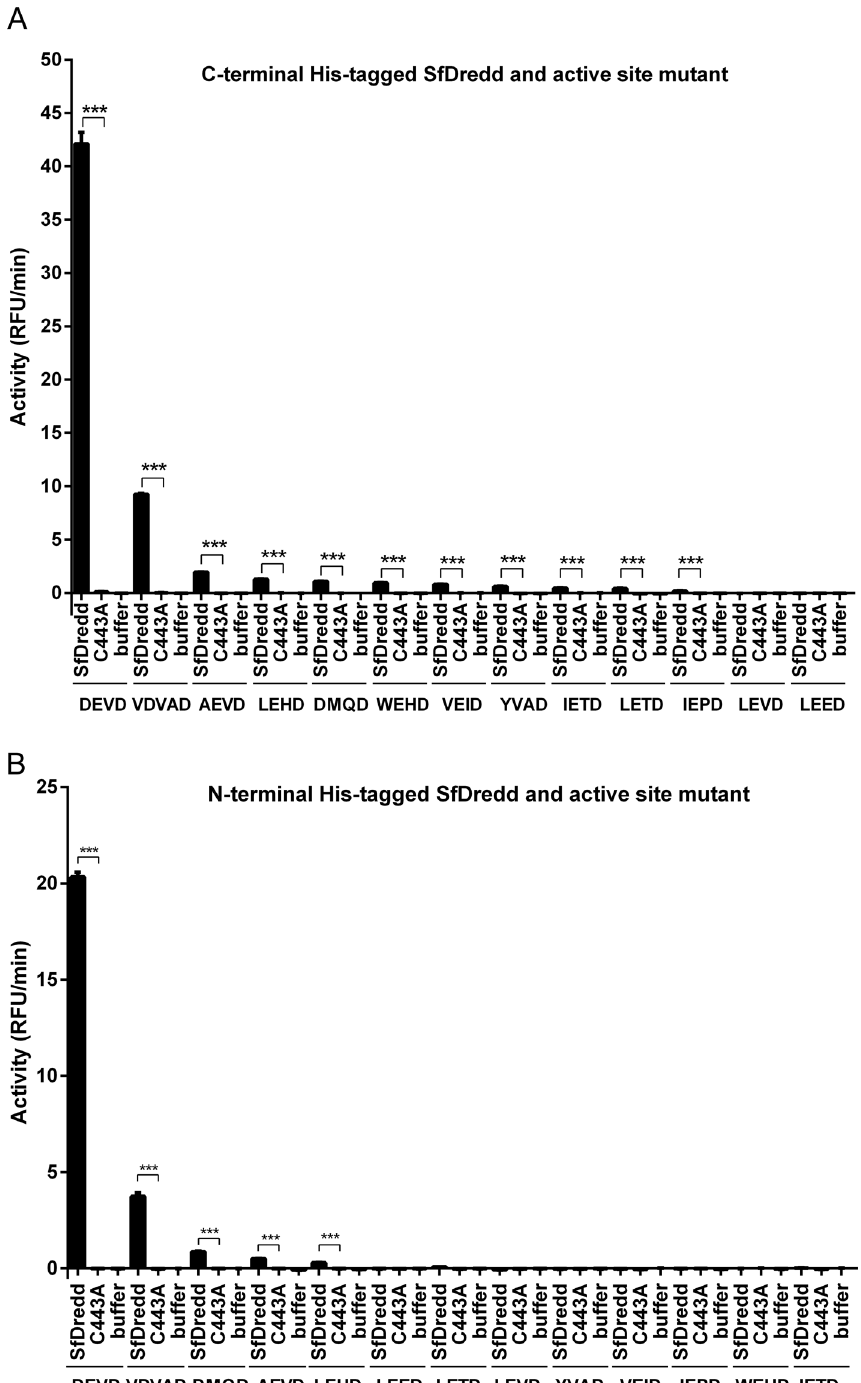
Fig 4. Recombinant SfDredd possessed the strongest activity on effector caspase substrates. Wild type SfDredd and active site mutant SfDredd-C443A with C-terminal His-tag (A) or N-terminal His-tag (B) were incubated, respectively with 13 types of synthetic caspase substrates (20 μ mol/L) and subjected to caspase activity assay. Caspase activity was indicated as the changes in relative fluorescence units (RFU) per minute. The data were presented with the SD from three independent experiments, and statistical significance was calculated by t test, *** P < 0.001.